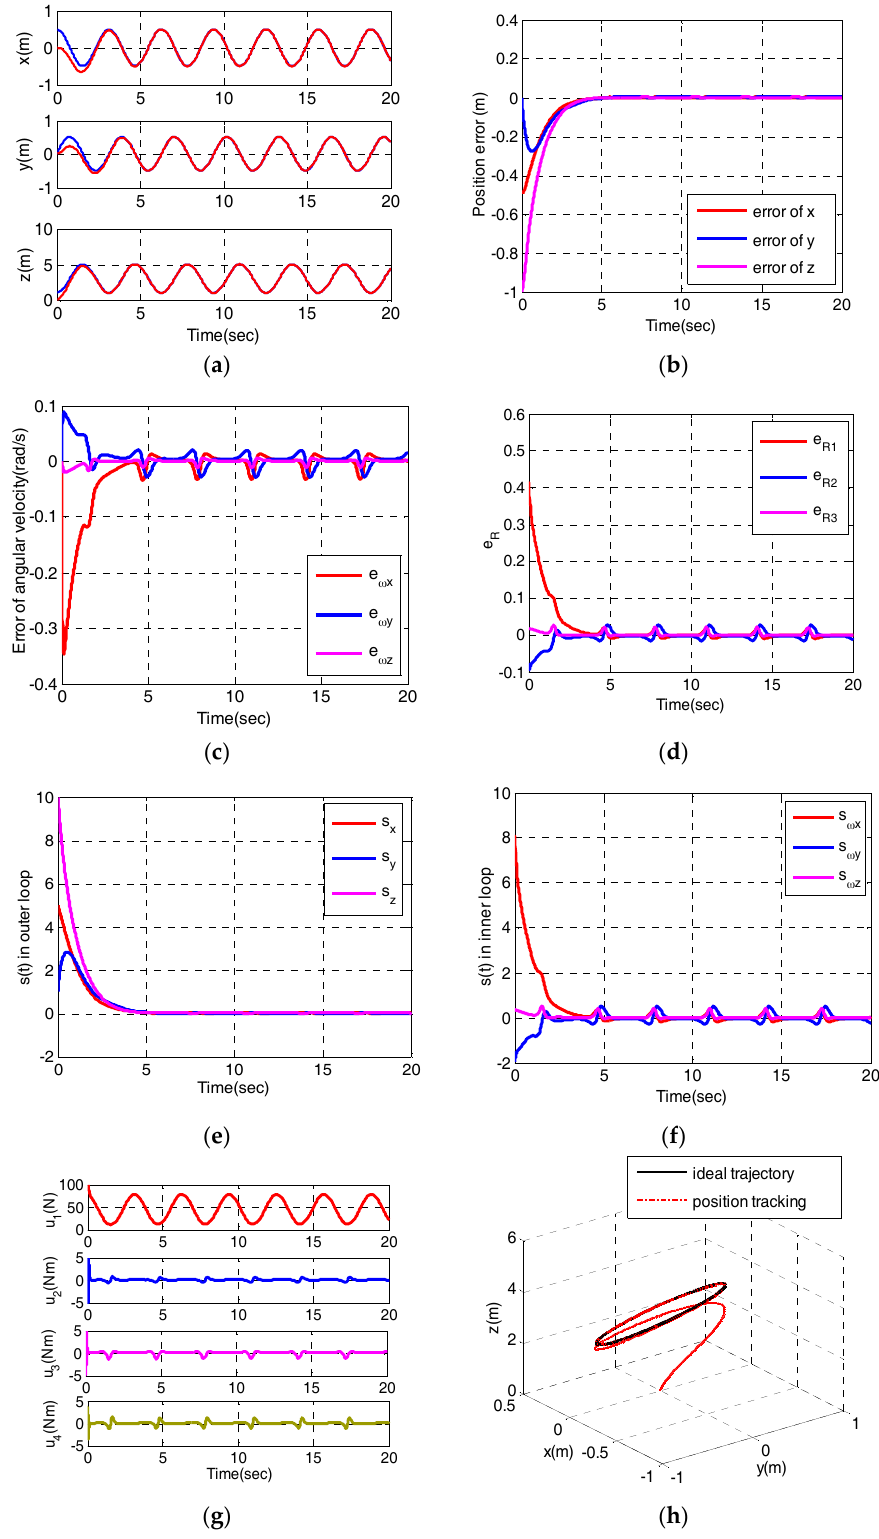
Figure 5. Tracking circular trajectory simulation ( a ) Position; ( b ) Error of position; ( c ) Error of angular velocity; ( d ) Vector form attitude error; ( e ) The sliding variables in outer loop; ( f ) The sliding variables in inner loop; ( g ) The control variables; ( h ) The desired trajectory and the actual trajectory in the simulation.